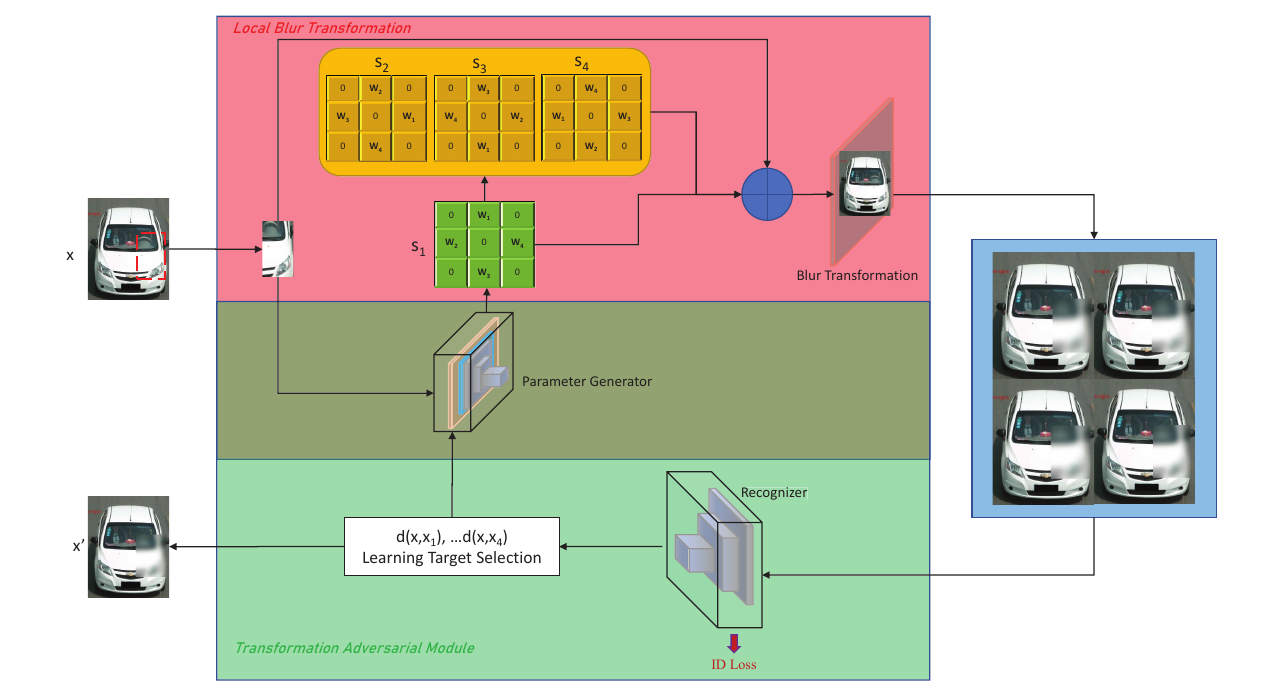
Figure 2. Overview of the proposed framework. It consists of two major modules: local blur transformation (red part) and transformation adversarial module (green part). Transformation adversarial module is the main idea of the system. In detail, the parameter generator network learns from the selected filter matrix transformation, and the recognizer learns more to judge the augmented image sample. Both are continuously updating themself to lift network performances. Note that parameter generator is employed both in local blur transformations and the adversarial